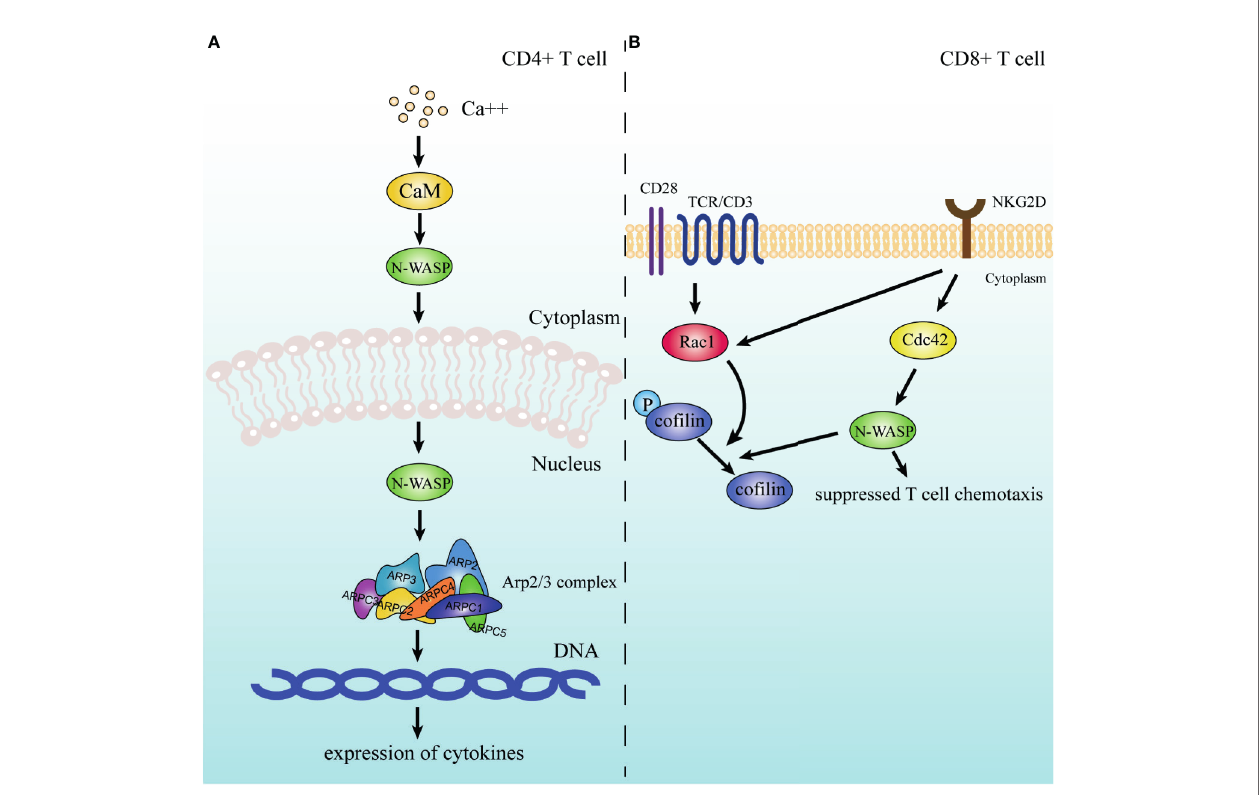
FIGURE 4 | N-WASP is involved in signaling pathways of T cells. (A) In CD4 + T cells, N-WASP is activated by CaM and enters the nucleus to coordinate the Arp2/3 complex to participate in the expression of cytokines. (B) In CD8 + T cells, N-WASP receives signals from NKG2D and participates in downstream co fi lin dephosphorylation while also mediating the inhibition of cellular